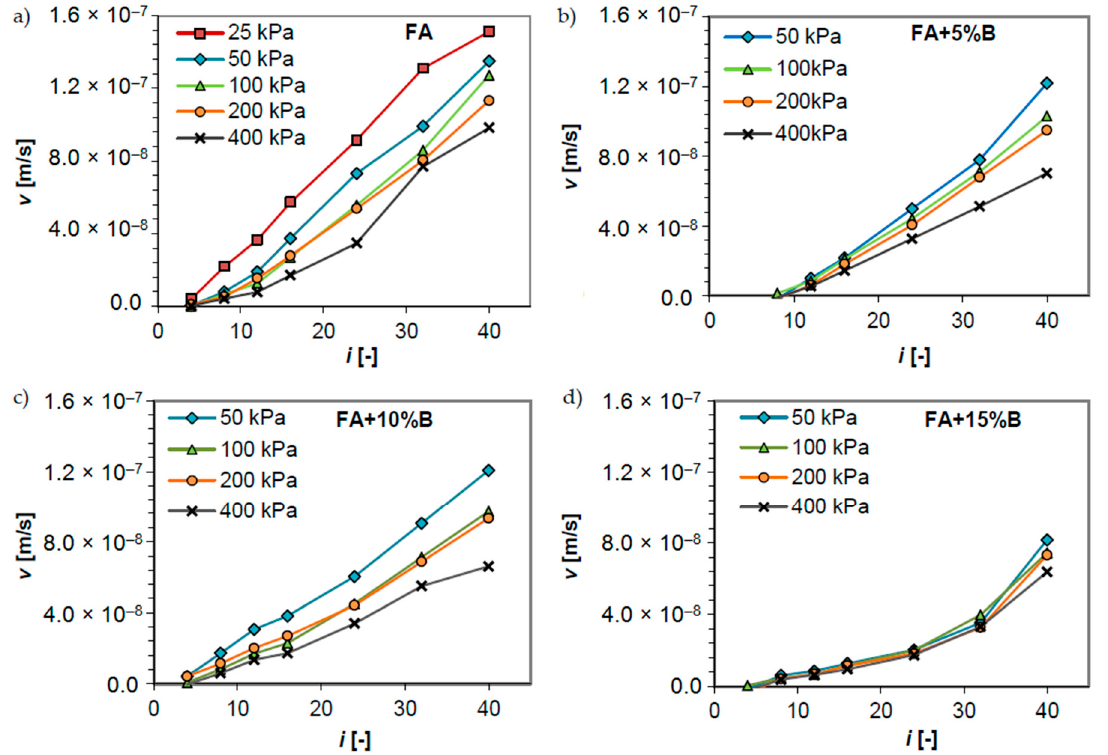
Figure 7. Flow velocity at a hydraulic gradient under variable e ff ective stresses for the samples of: ( a ) fly ash, ( b ) fly ash with 5% of bentonite, ( c ) fly ash with 10% of bentonite, and ( d ) fly ash with 15% of